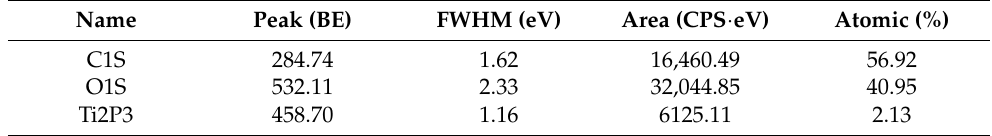
Table 1. Elements composition and quantitative evaluation of samples of treated